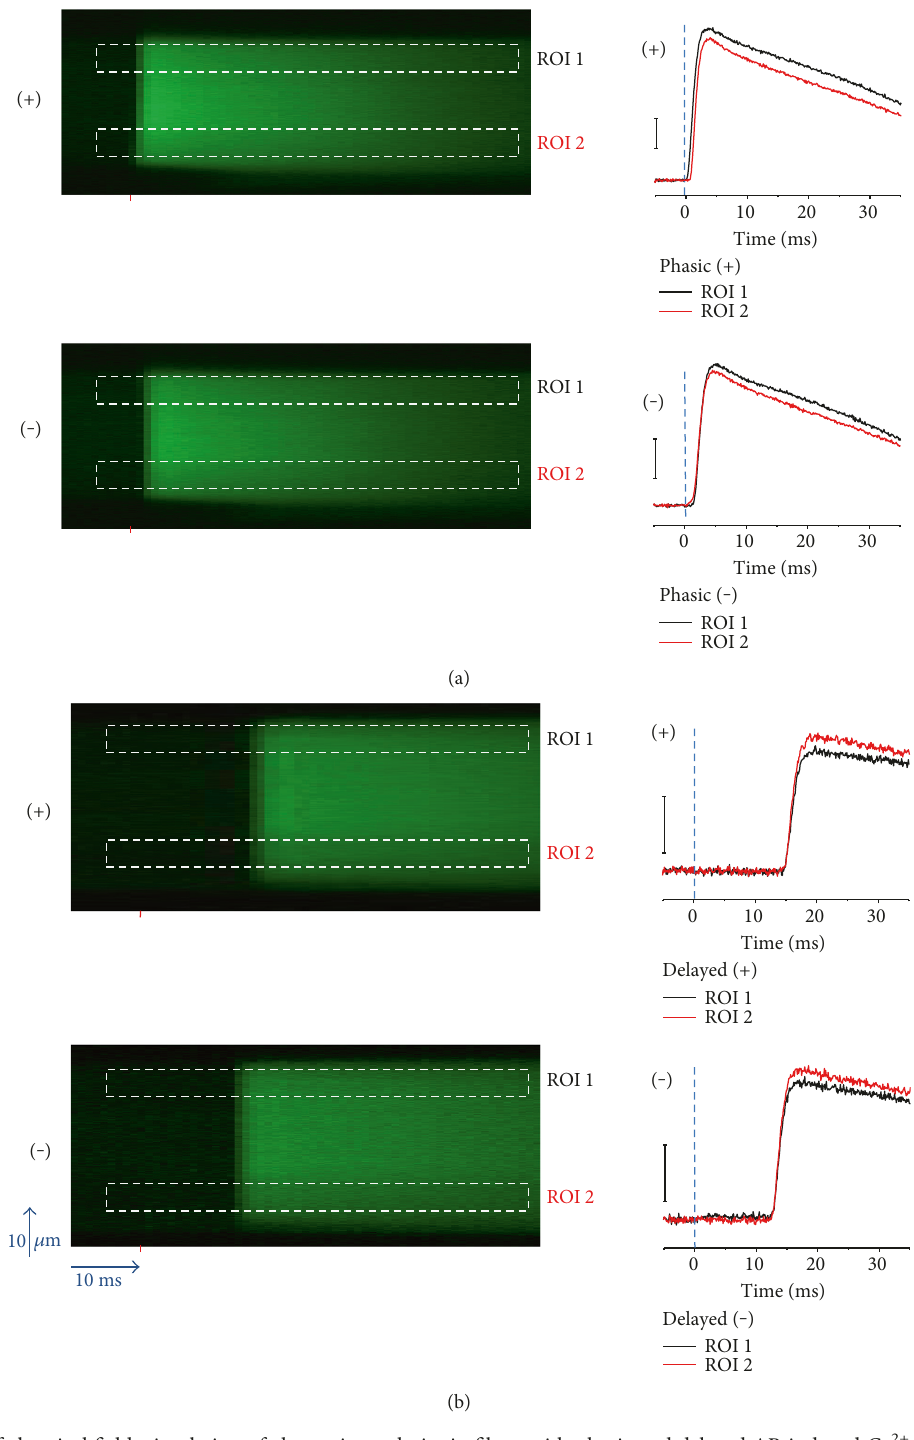
Figure 3: E ff ect of electrical fi eld stimulation of alternating polarity in fi bers with phasic and delayed AP-induced Ca 2+ transients. (a) Left , line-scan images of phasic AP-induced Ca 2+ transients elicited by fi eld stimulation of alternate polarity and measured in two di ff erent regions of interest (ROIs); right , time course of the phasic AP-induced Ca 2+ transients measured at two ROIs (ROI 1 and ROI 2) and elicited by the stimulus of positive ( upper traces ) or negative polarity ( lower traces ) at the fi ber end where the recordings were made. (b) Left , line-scan images of phasic-delayed AP-induced Ca 2+ transients elicited by fi eld stimulation of alternate polarity and monitored in two ROIs; right , time course of the delayed AP-induced Ca 2+ transients measured at two ROIs and elicited by the stimulus of positive ( upper traces ) or negative polarity ( lower traces ) at the fi ber end where the recordings were made. The red mark in line-scan images indicates the time when the fi eld stimulus was applied; the dashed rectangles illustrates the location of the